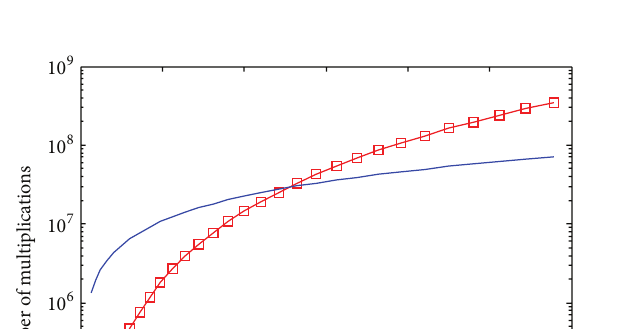
Figure 3: Computational complexity according to the size of the virtual array when 𝑁 = 128 .